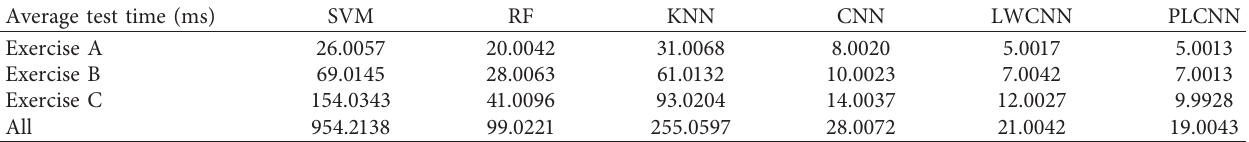
Table 6: Average test time of six algorithms.